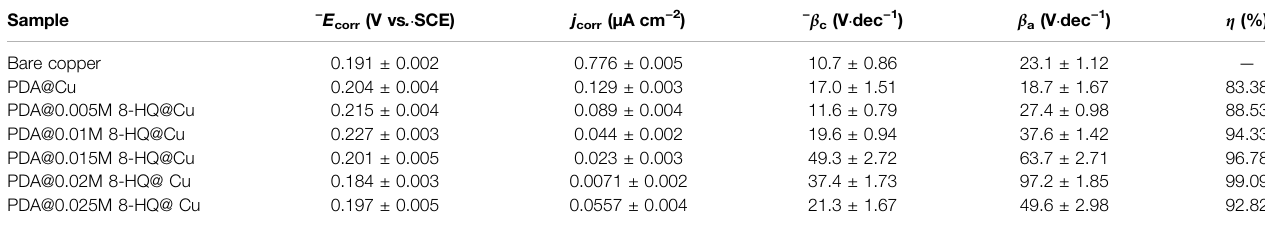
TABLE 2 | Corrosion parameters obtained from potentiodynamic polarization curves for different samples in 3.5 wt.% NaCl aqueous solution (The error means a standard deviation of three measurements).